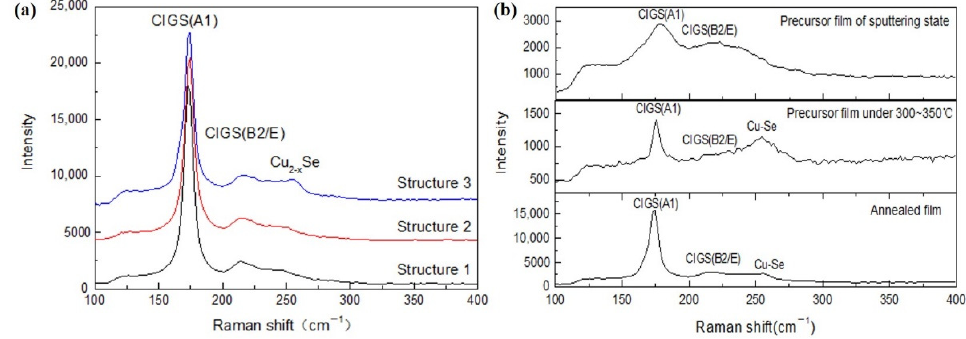
Figure 5. Raman spectra of CIGS films. ( a ) Raman spectra of annealed films, ( b ) Raman spectra of structrue3 film under different state.